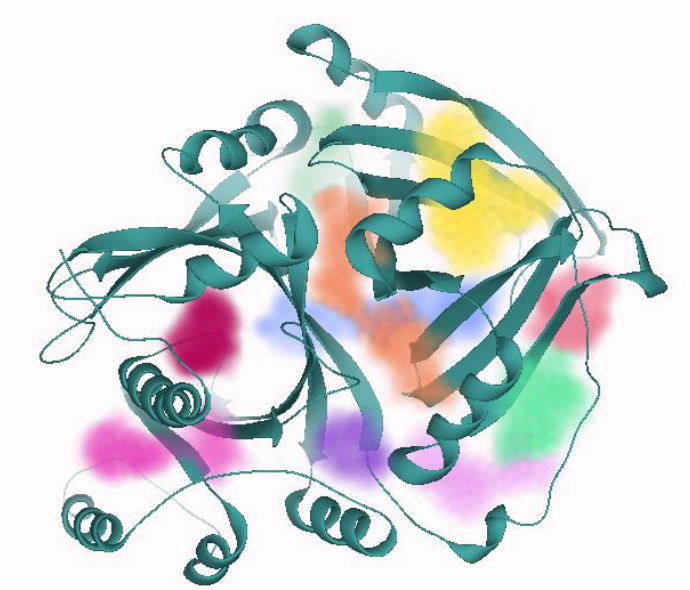
Figure 3. A visualization of all the unoccupied binding sites in 4-hydroxyphenylpyruvate dioxy- genase. It consists of a total of 10 binding pockets represented by different colors, but the one represented in yellow is selected for having the highest DoGSiteScore. The color of each unoccupied site is numbered and described in Table 1. Table 1. Unoccupied binding pockets predicted via binding mode in